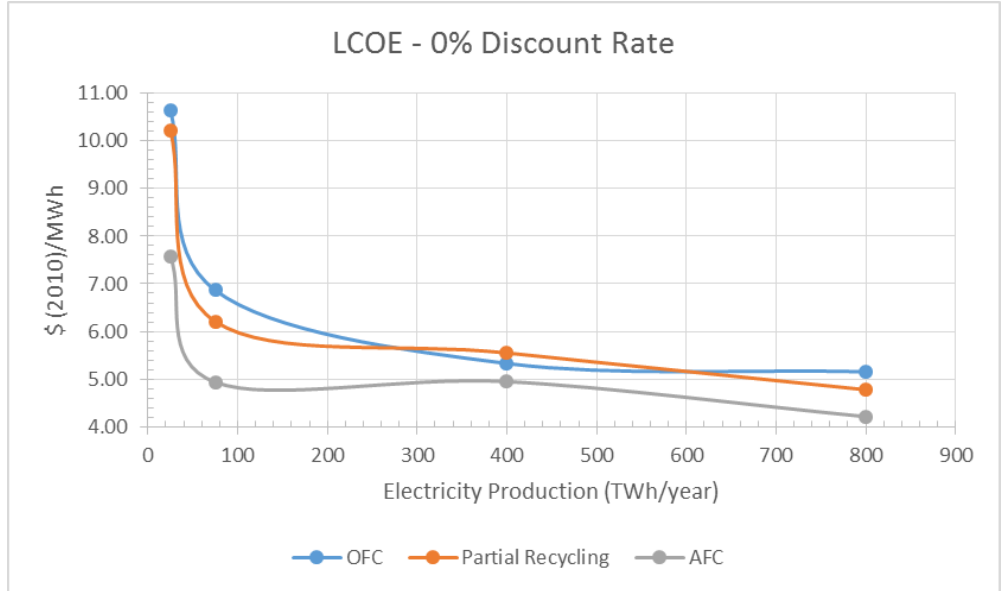
Figure 10. LCOE for different backend strategies: 0% discount rate.